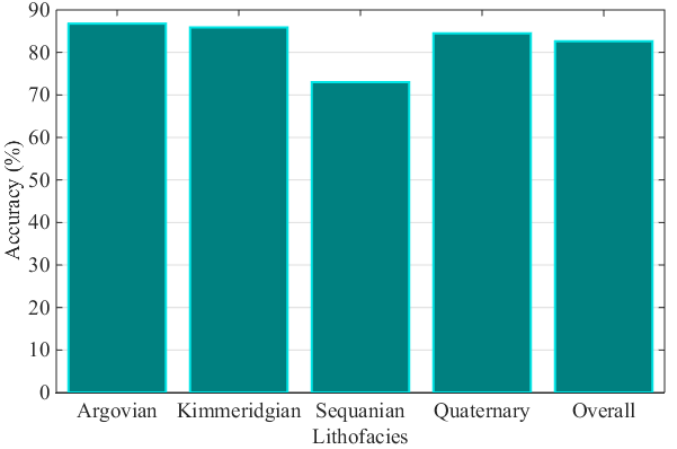
Figure 3. Prediction accuracy comparison.